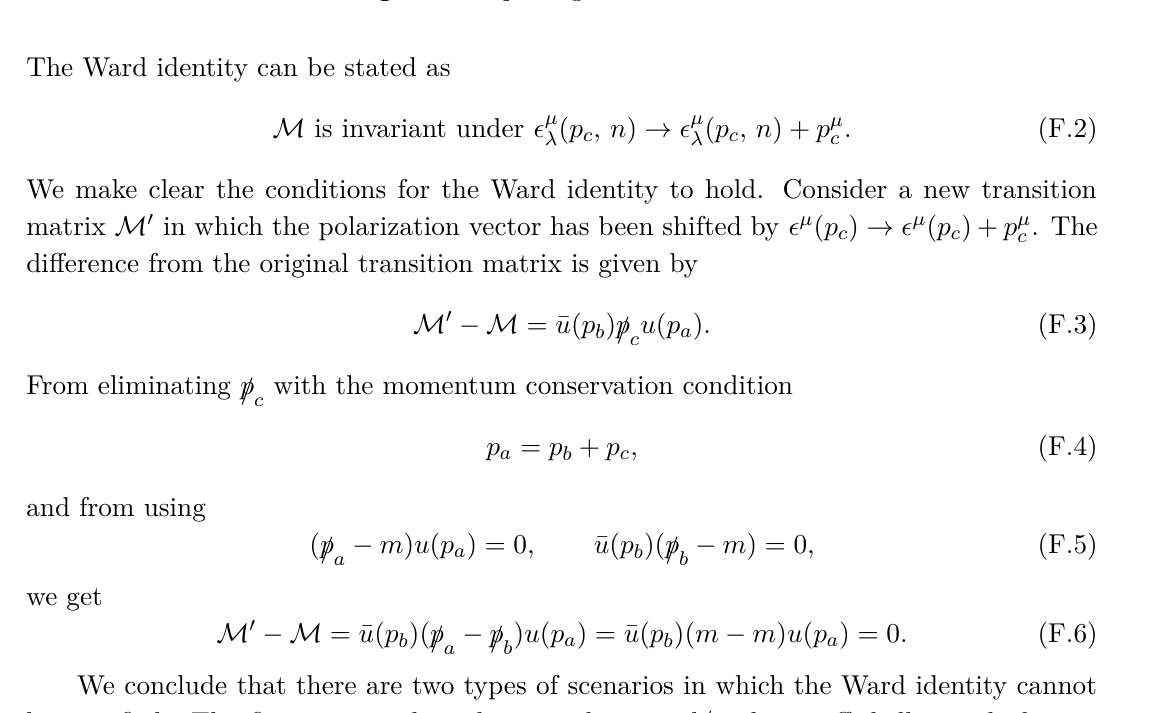
Figure 15 . Splitting radiation